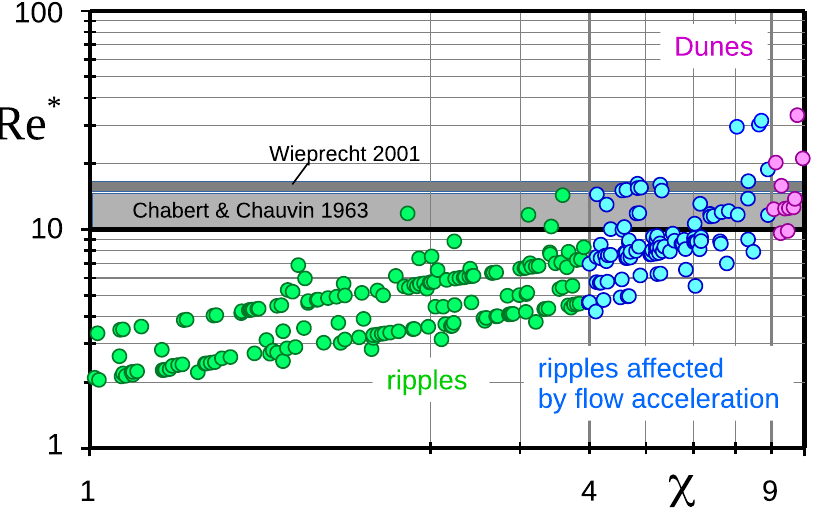
Figure 11. Re (cid:63) at the upper limit of the ripple domain from the data set used and from two data-based diagrams from the literature (Chabert and Chauvin 1963 and Wieprecht 2001) as an example. For data source, see Section